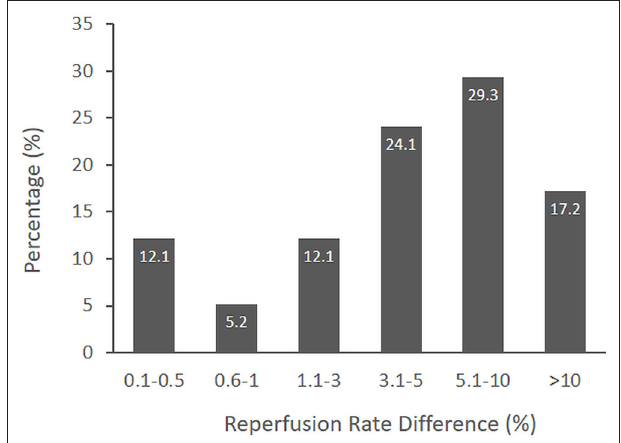
FIGURE 1 | The distribution of MCID responses from surveyed international experts. The median MCID of a novel thrombectomy device to